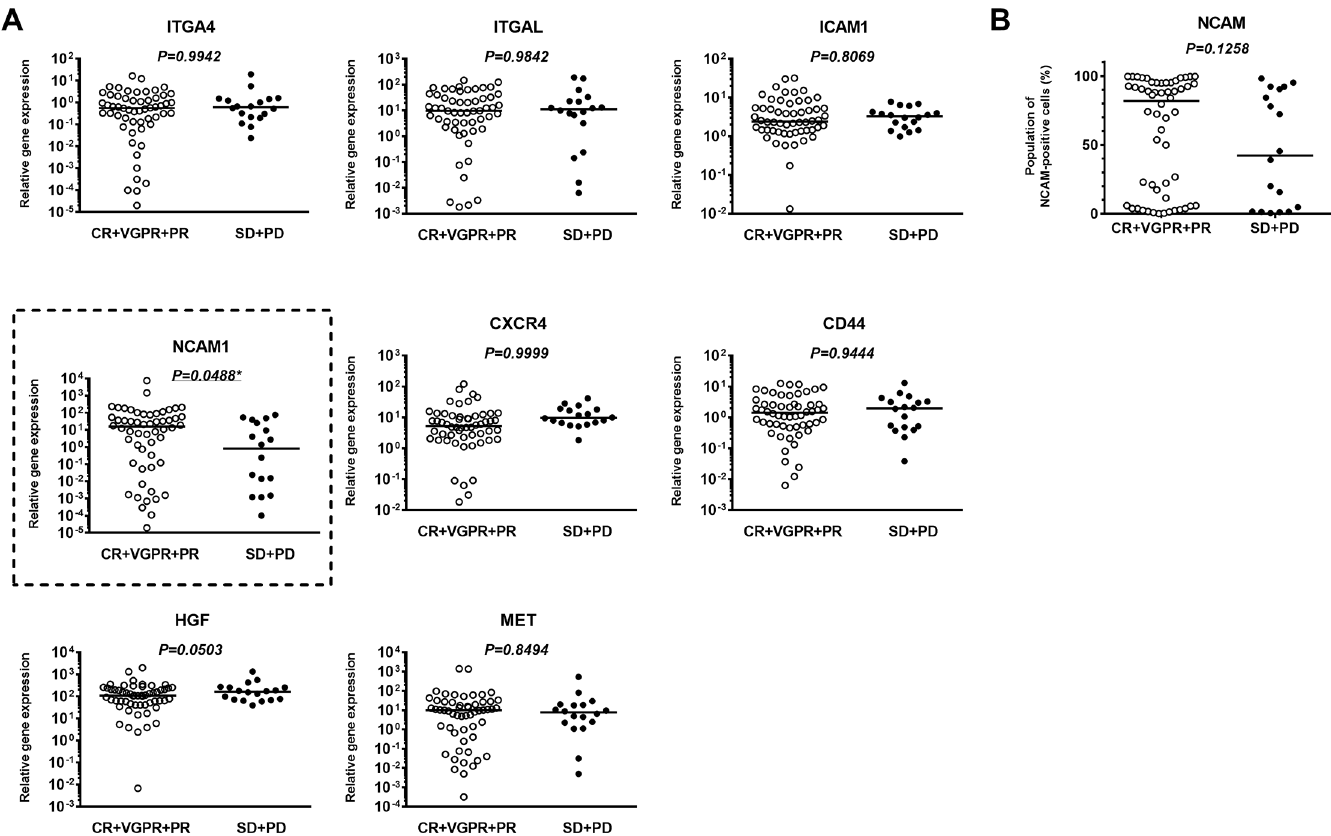
Fig 1. Comparison of levels of cell adhesion molecules between good and poor responders to bortezomib plus dexamethasone (Bd) therapy. (A) Comparison of the expression of several genes associated with cell adhesion molecules among good responders (CR+VGPR+PR) and poor responders (SD+PD) to Bd therapy. (B) Comparison of cell-surface expression of NCAM by FACS among the good and poor responders to Bd therapy. (cid:3) indicates statistical significance ( p < 0.05) as calculated by a Mann–Whitney U test.